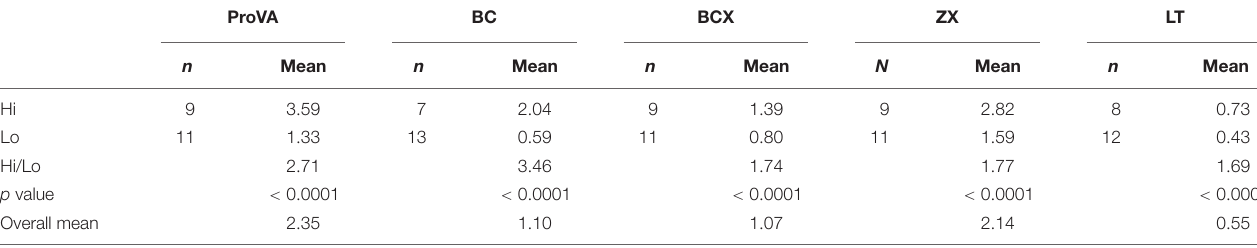
TABLE 1 | Numbers of hybrids and mean carotenoid concentrations ( µ g g − 1 dry weight) for F2 grain of hybrids grouped as high (Hi) and low (Lo) for carotenoids concentrations.